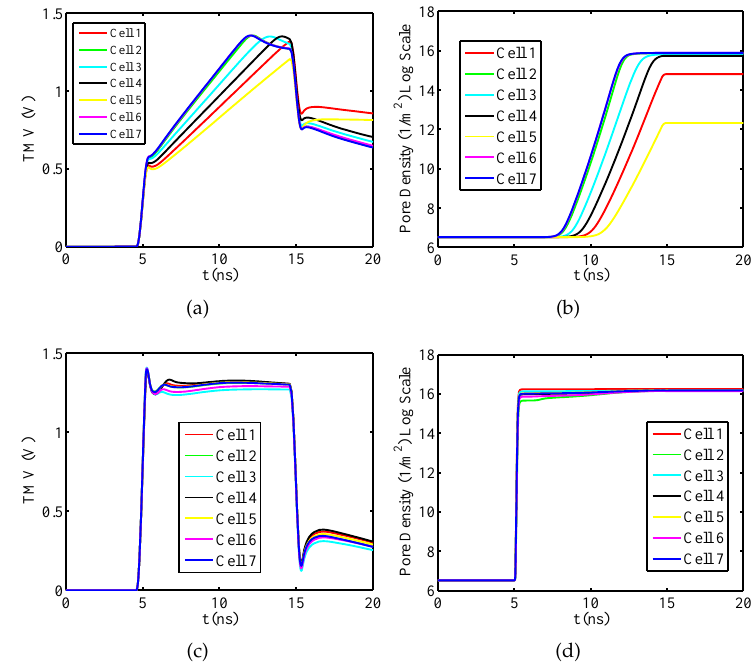
Figure 4. Packed System—Temporal evolution of ( a ) TMV and ( b ) pore density for plasma membranes at the angular placement θ = 75 ◦ . Temporal evolution of ( c ) TMV and ( d ) pore density for nuclear membranes at the angular placement θ = 75 ◦ . Pulse amplitude and duration equal to 100 kV/cm and 10 ns, respectively.